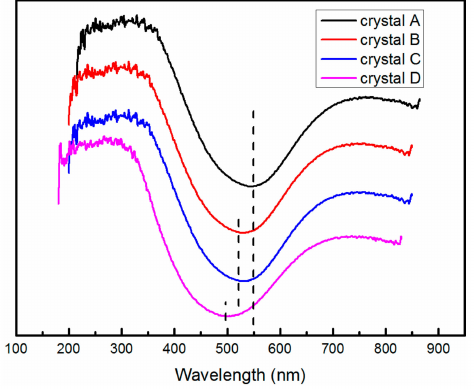
Figure 8. UV-Vis spectra of the crystal A, crystal B, crystal C and crystal